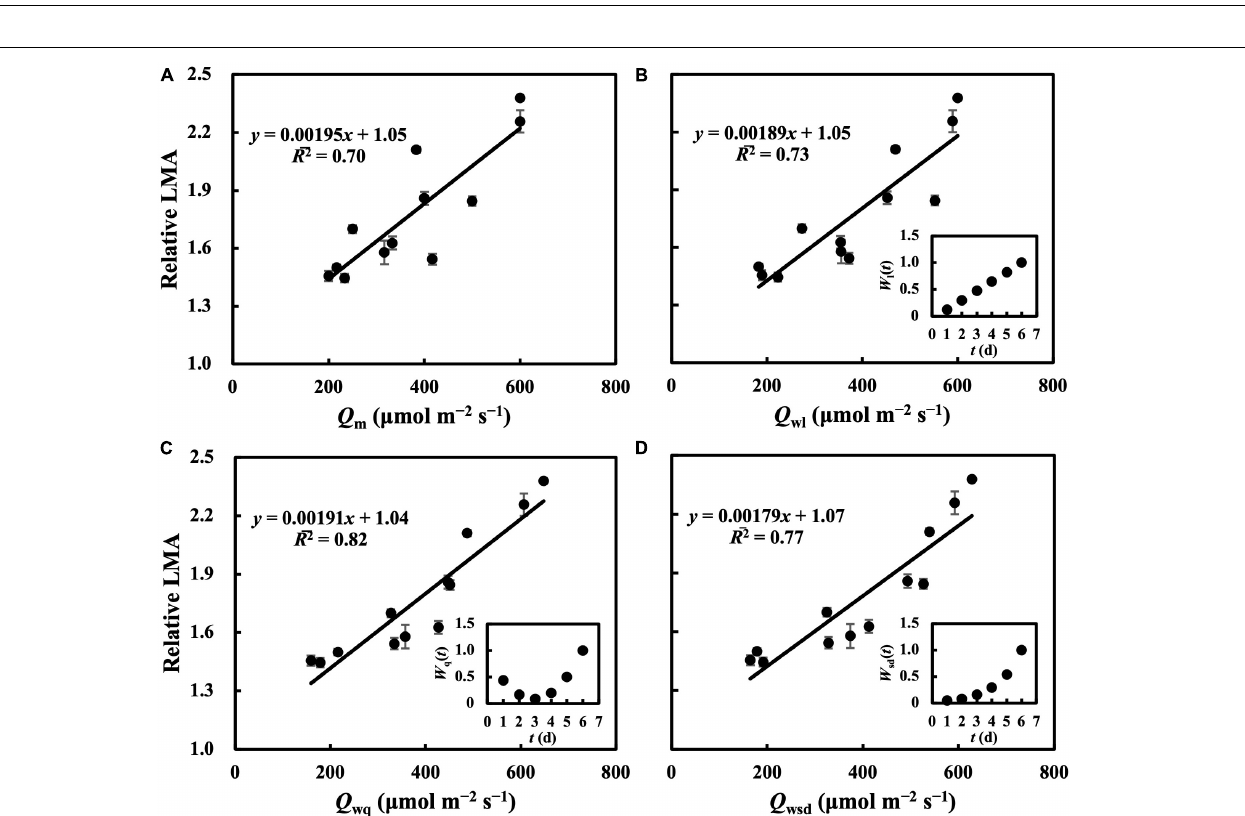
FIGURE 2 | Linear regression of relative LMA on average PPFD ( Q m ) (A) , time-weighted average PPFD in linear type ( Q wl ) (B) , in quadratic type ( Q wq ) (C) , in sigmoid derivative type ( Q wsd ) (D) . First true leaves of cucumber seedlings were acclimated to randomly assigned PPFD treatments in the first experiment. All values were means ± standard errors ( n = 3) and relativized to that for 100 µ mol m − 2 s − 1 . Regression lines, regression functions, and R 2 are shown. Corresponding weights of Q wl [ W l ( t )], Q wq [ W q ( t )], Q wsd [ W sd ( t )] in t day which achieved the minimum RMSEs of estimation of LMA are shown. See section “Statistics” for details of